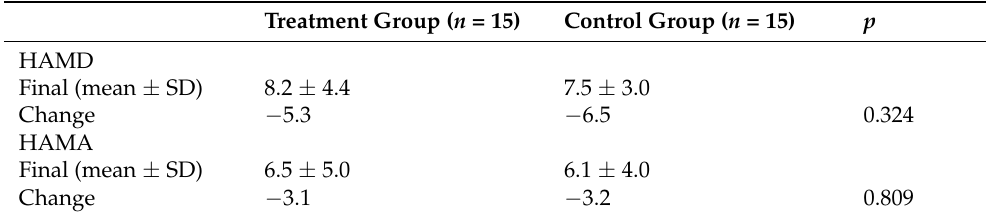
Table 5. Comparison of the HAMD and HAMA scores between the treatment and control